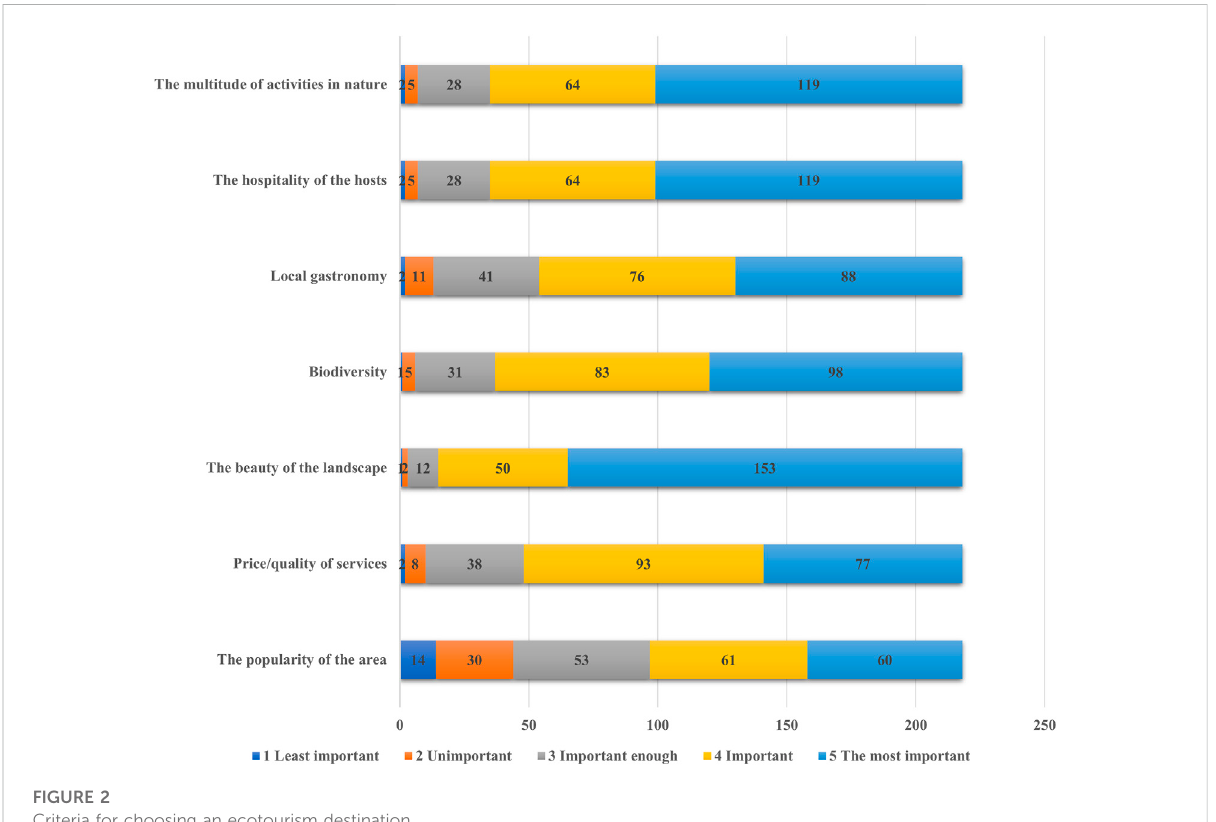
FIGURE 2 Criteria for choosing an ecotourism destination.